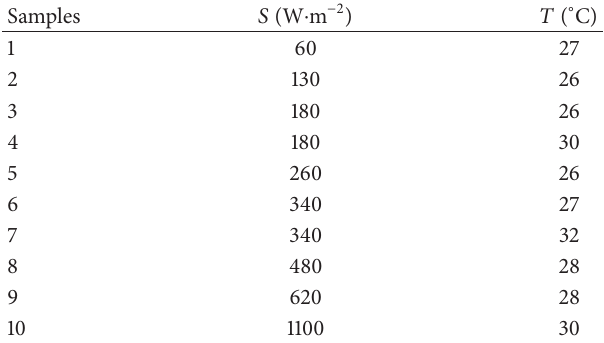
Table 2: Weather conditions of 10 samples.